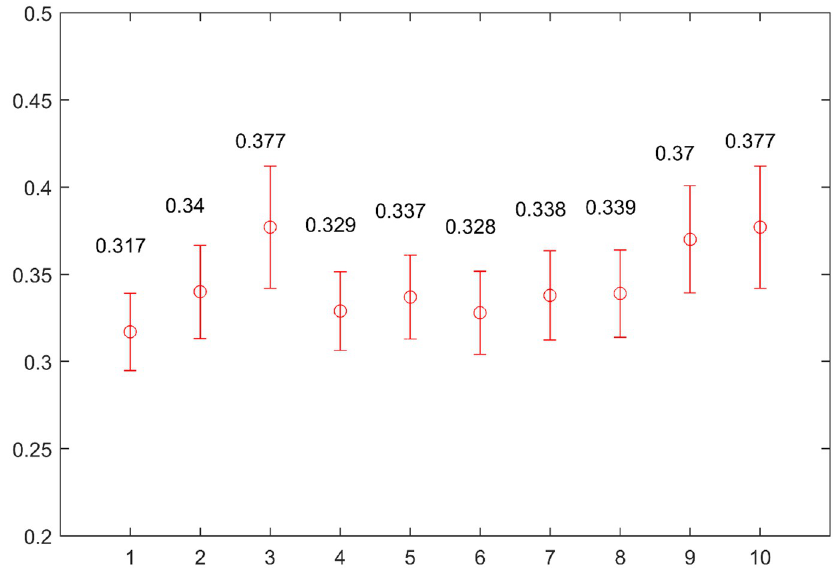
Fig 17. Mean and standard deviation of N-RMSD in the 4DCT sorted by proposed Amp-sim-w method according to the ratio of each objective information.